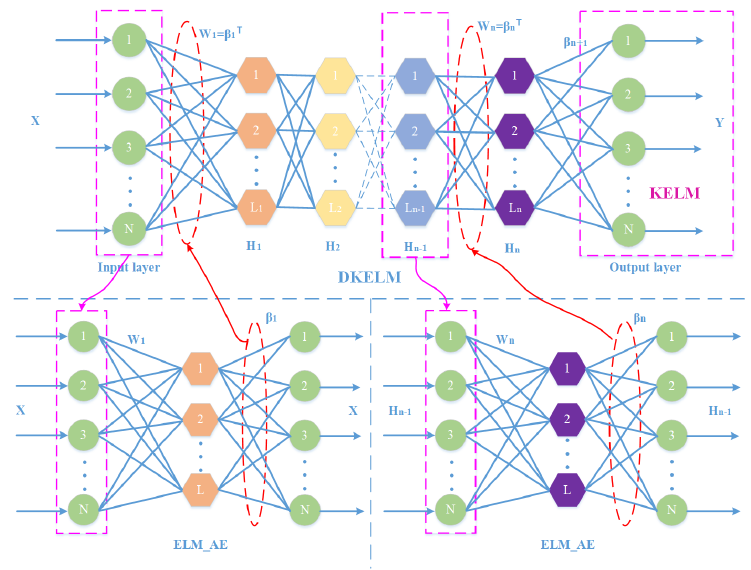
Figure 3. Structure diagram of